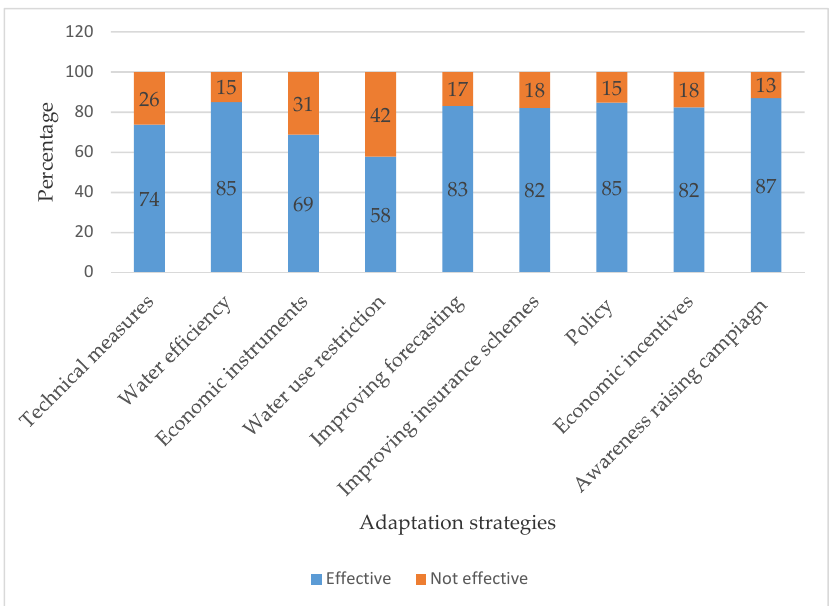
ff ectiveness of di ff erent adaptation measures. Source: authors’ Figure 4. Effectiveness of different adaptation measures. Source: authors’ calculations. Figure 4. E